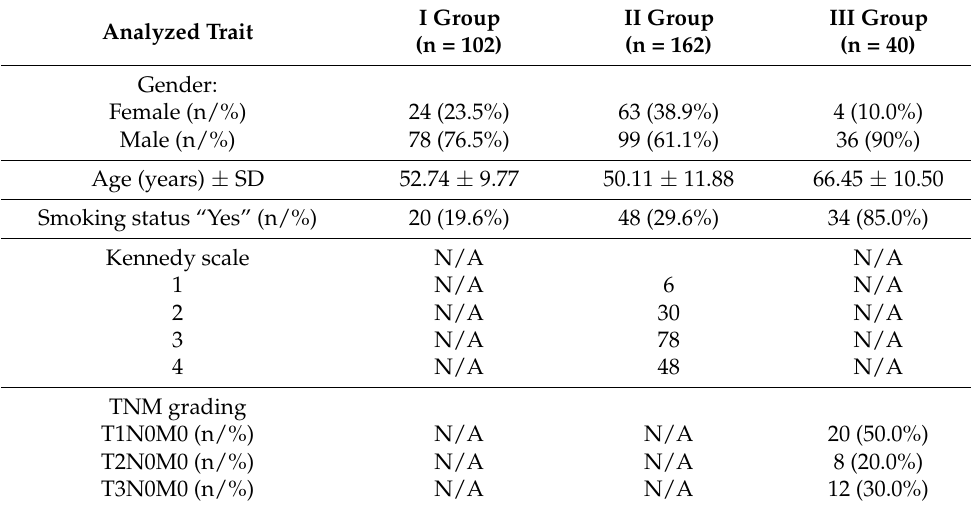
Table 1. Participants’